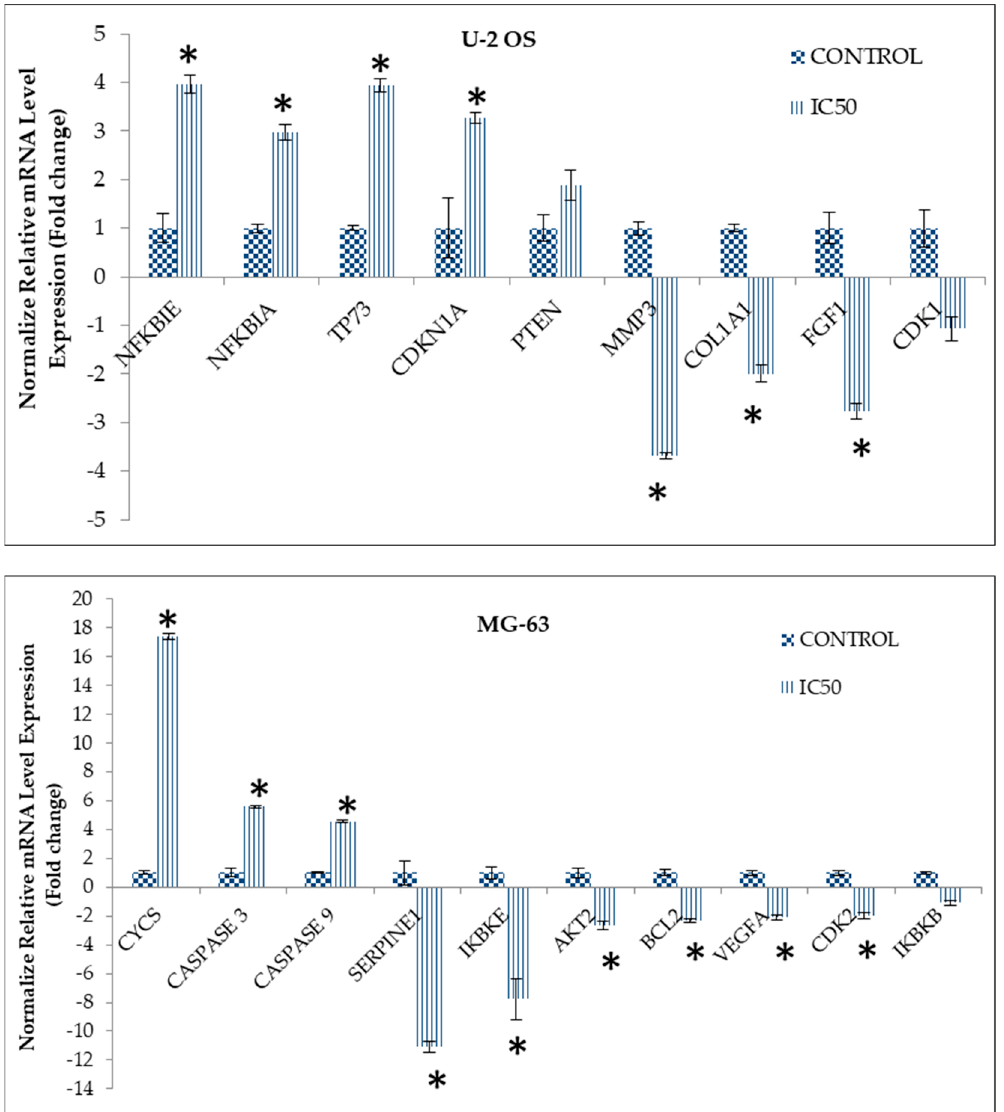
Figure 6. The differential expression of regulated genes in both U-2 OS ( top ) and MG-63 ( down ) were validated using quantitative real-time PCR (qPCR). All validated genes were mostly involved either in metastasis or angiogenesis process in osteosarcoma cell lines treated with DK1 (IC 50 ) for 48 h. The expressions of all genes were normalized to GUSB and ACTB housekeeping genes. The analysis were done in triplicate and expressed as mean ± standard error mean (S.E.M). The significant of the data was set at * p < 0.05 and fold changes more than 2 which compared between untreated control group and the DK1 treated group. Table 3. Metastasis and angiogenesis related proteins expression in DK1 treated group for both U- 2 OS and MG-63 osteosarcoma cell lines.